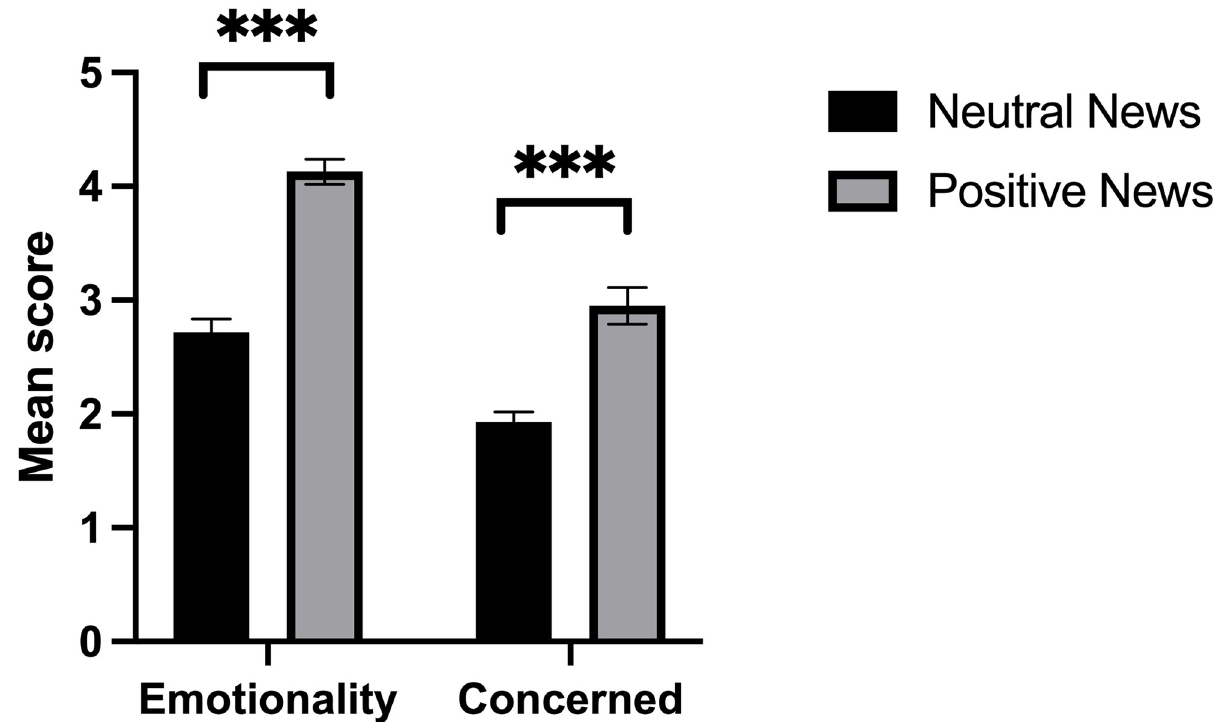
Fig 2. Mean score on emotionality and concerned about the news as a function of condition. Non-adjusted means are presented and errors bars are the standard error of the mean. ��� p < 0.001.